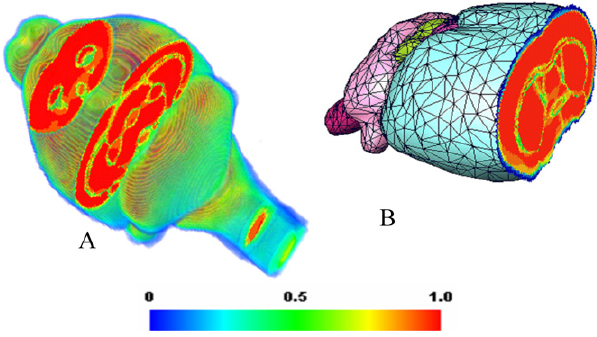
Figure 10. (A) The 3D in vivo probabilistic atlas with three cross sections at dif- ferent locations. The colors in the cross section show at each voxel the maximum probability of the common structure occupied by the normal C57BL/6J mouse brains ( n = 12) after rigid-body alignment. The bright red color corresponds to high probability; blue color corresponds to low probability. (B) One cross section of the in vivo probabilistic atlas is displayed together with the average brain surface (The colors on the brain surface represent different